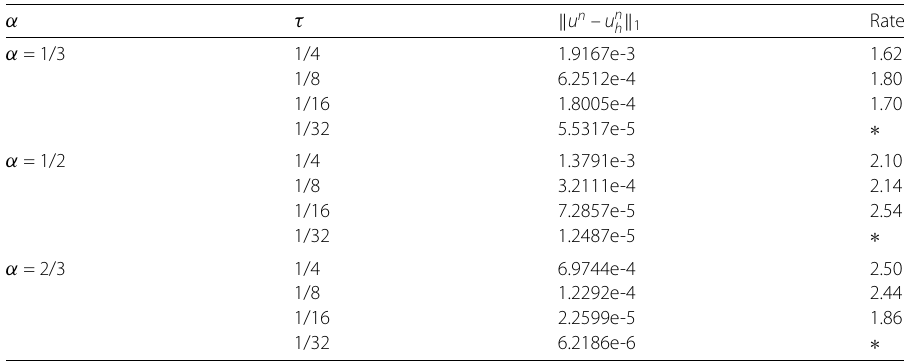
Table 7 Numerical errors and convergence orders in temporal direction with h = π T = 1 for Example